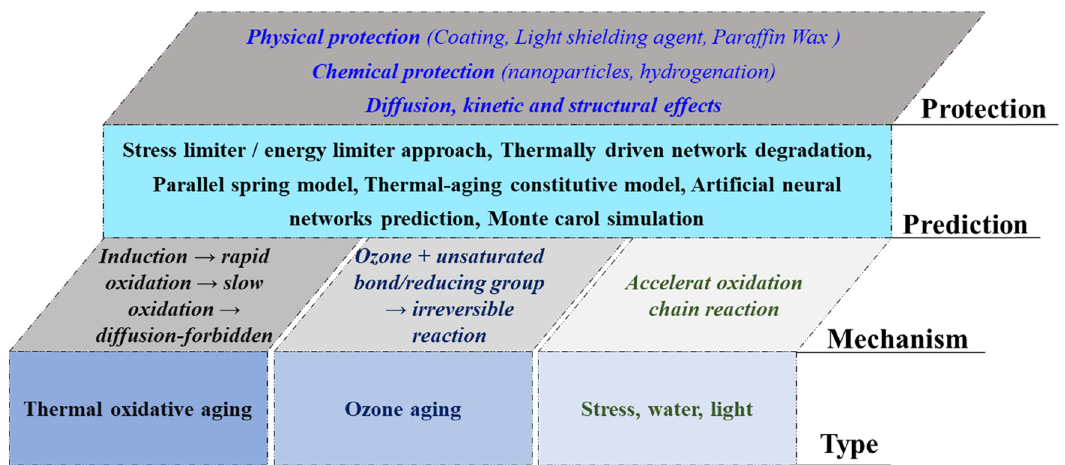
Figure 3: Research progress of rubber material